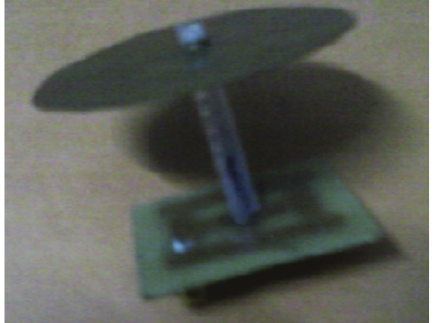
Figure 12: Side view of proposed antenna.